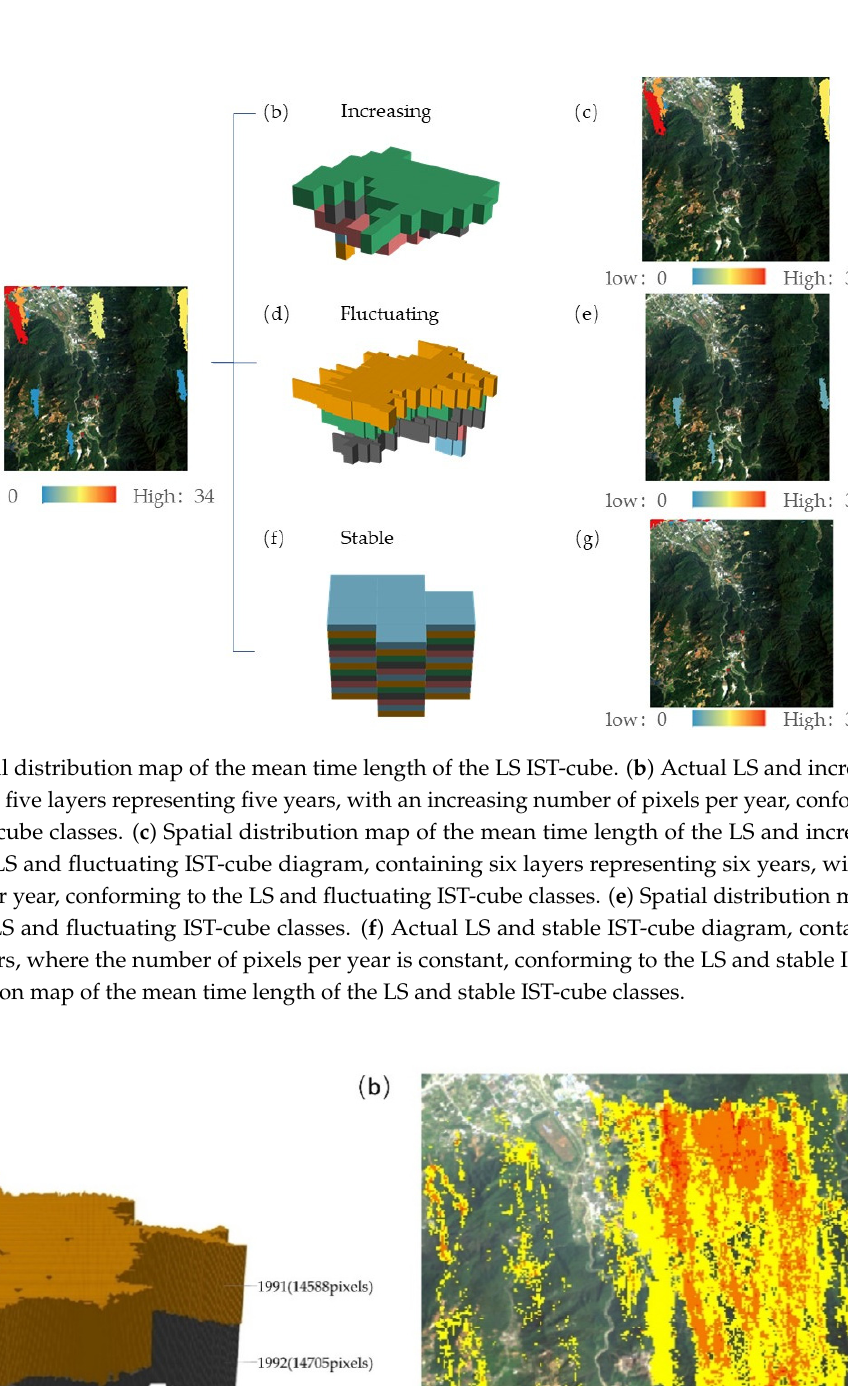
Figure 12. Precipitation and drought for 1987–2019. ( a ) Maximum precipitation and flood threshold for 10 consecutive days and ( b ) proportion of drought periods. Table 2. Occurrence of floods, droughts, and changes detected by the IST-cube for 1987–2019. Year